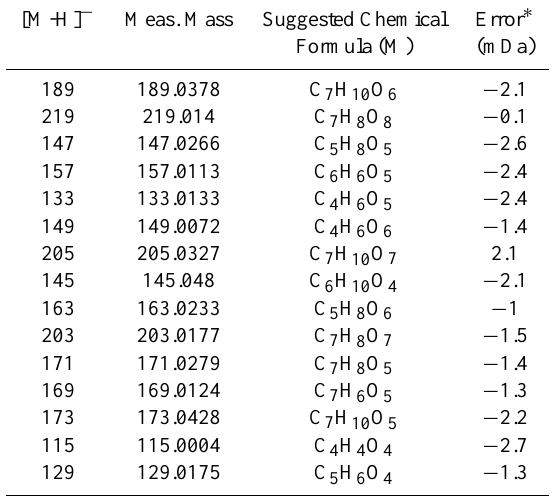
Table 5. SOA products observed in UPLC/(-)ESI-TOFMS offline filter analysis for the guaiacol low-NO x